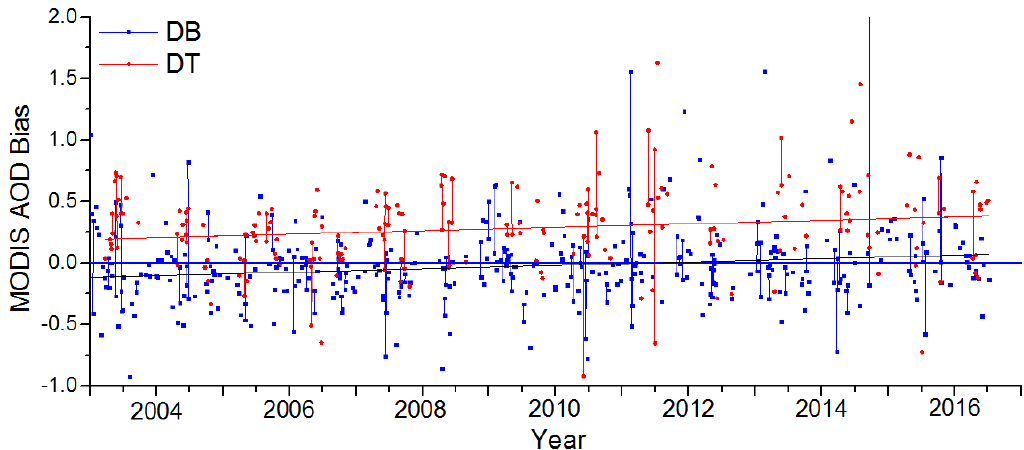
Figure 10. Daily bias of Aqua MODIS C6 DB and DT AOD (AOD 550 > 0.4) in Beijing from 2003 to 2016.